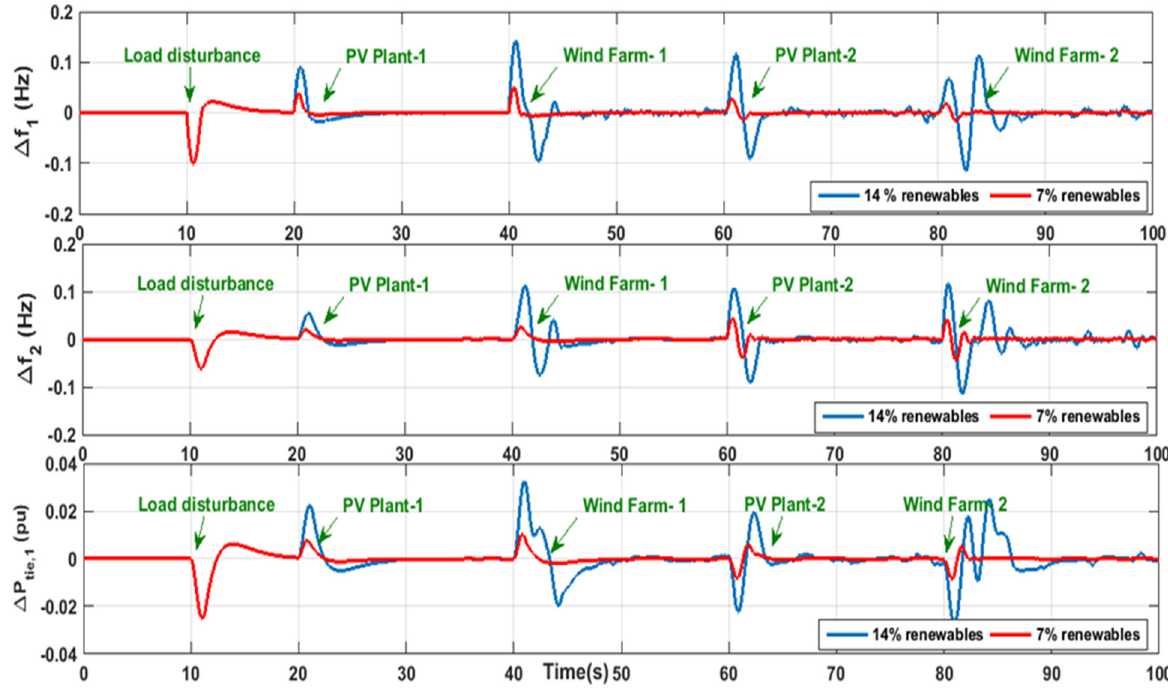
Figure 16. The system under consideration performance for scenario